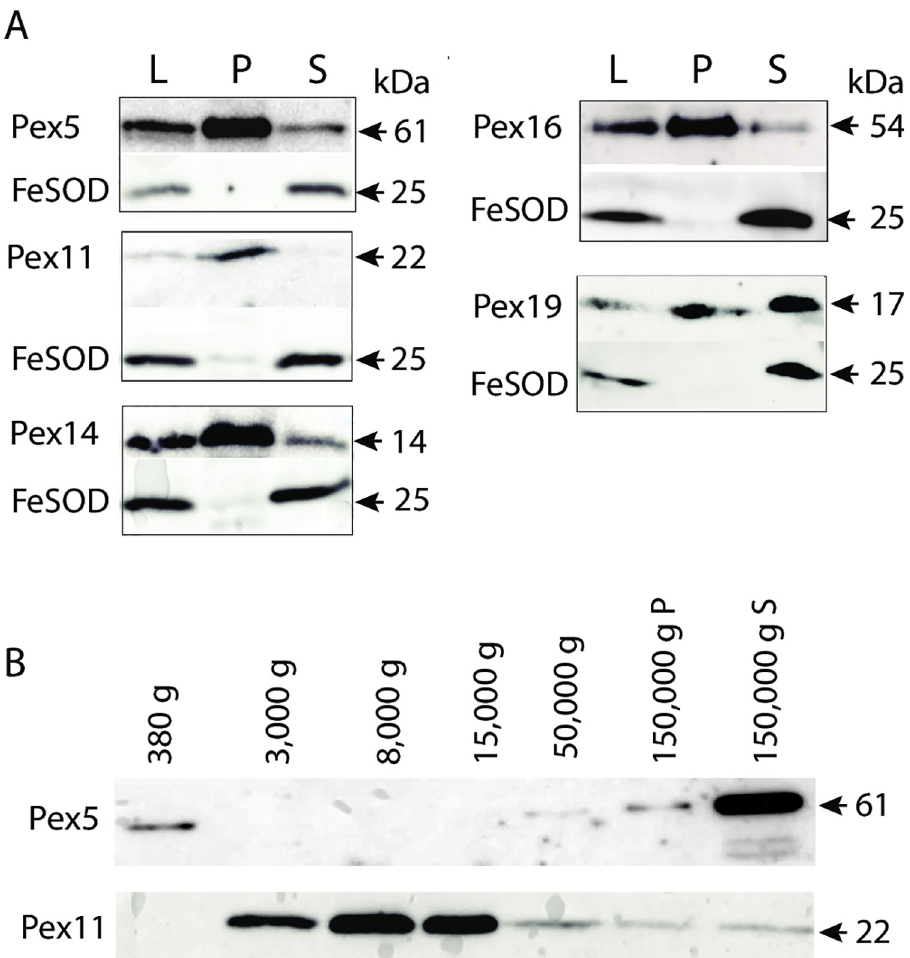
Fig 4. Expression of tagged PEXs in E . histolytica . A. Western blot analysis of cell lysate (L), organelle (P) and cytosolic soluble (S) fractions. Fe-superoxide dismutase (FeSOD) was used as the cytosolic marker. B. Western blot analysis of Pex5 and Pex11 in seven fractions isolated by differential centrifugation using 0.05% Tween-20 to limit protein aggregation.